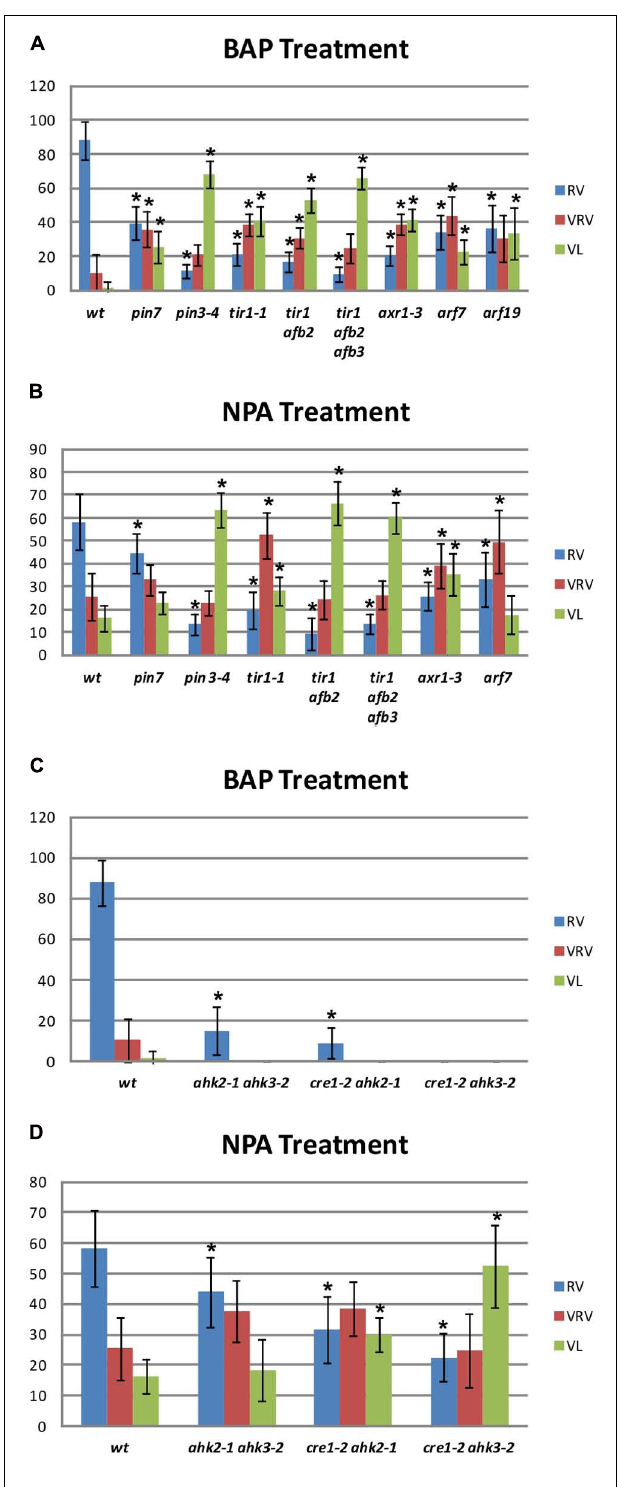
FIGURE 3 |Apical-basal gynoecium patterning phenotype frequency of NPA and BAP treatments in wild type and mutant backgrounds. (A,C) Distribution of the different categories of apical-basal phenotypes in BAP-treated gynoecia. (A) Auxin signaling mutants. Col, n = 204; pin7 , n = 111; pin3 , n = 204; tir1 , n = 145; tir1 afb2 , n = 299; tir1 afb2 afb3 ,